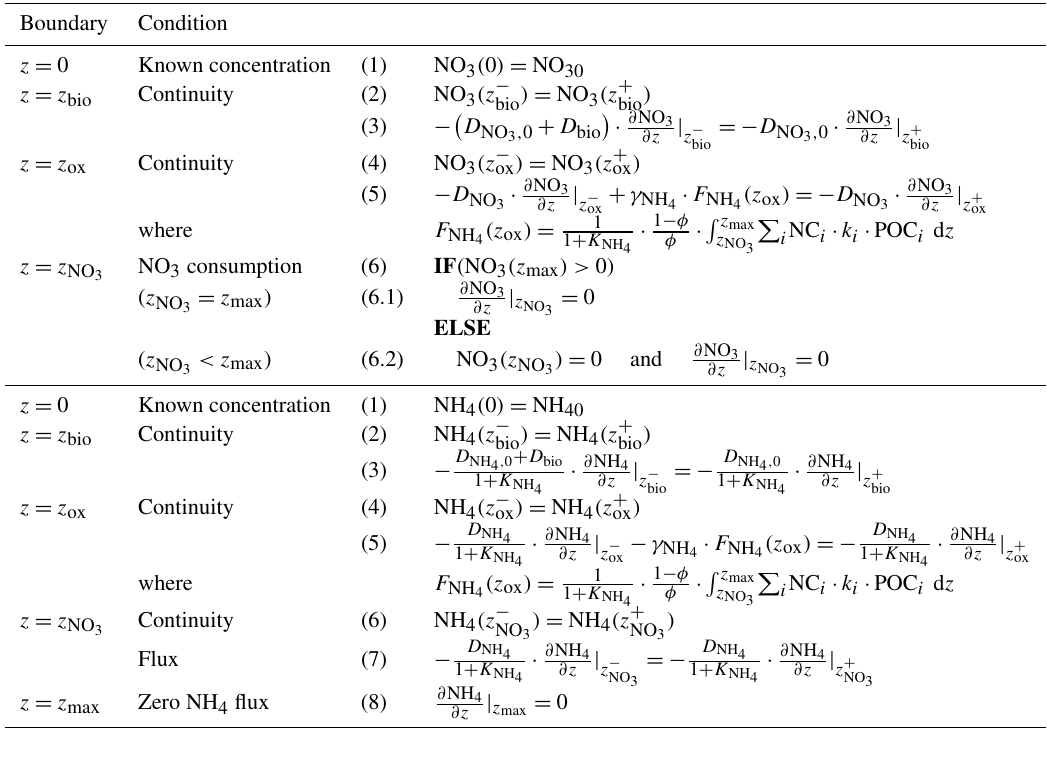
Table 4. Boundary conditions for nitrate and ammonium. For the boundaries we define z − __ = lim h → 0 (z __ − h) and z + __ = lim h → 0 (z __ + h) . Boundary